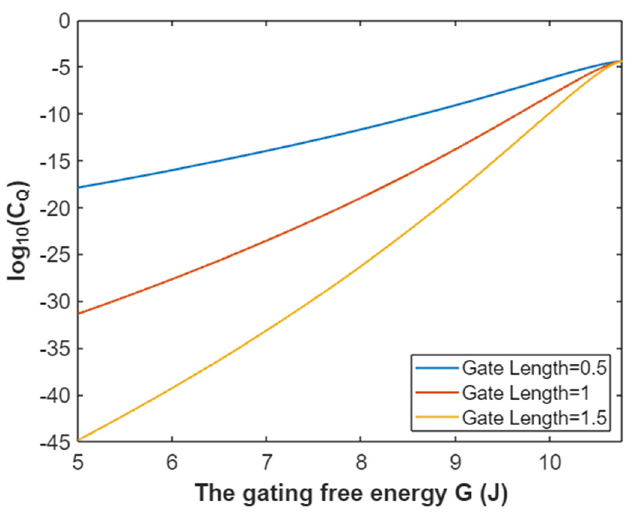
Figure 11. The relationship between gating free energy and the common logarithm of quantum